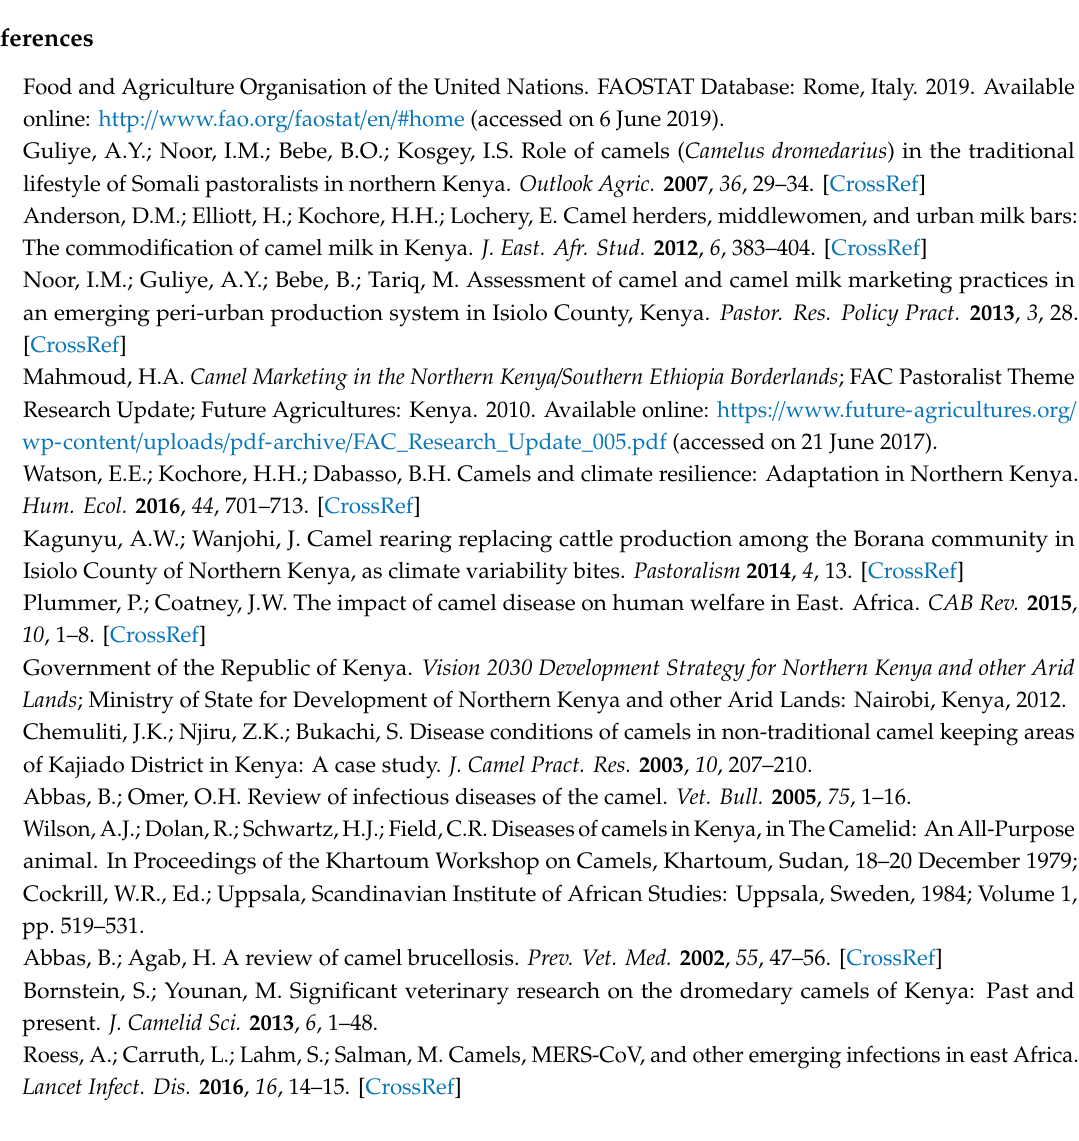
Figure S1: Title and abstract inclusion / exclusion protocol, Figure S2: Full-text inclusion / exclusion